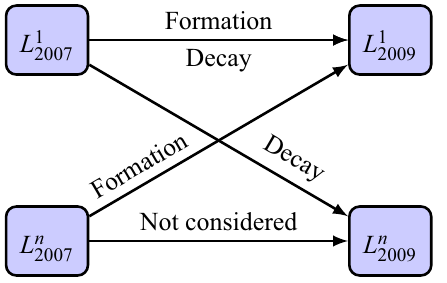
Figure 6. The relationships that have been considered for analyses. All pairs that were mutually in top 5 1 ranks in the year 2007 (represented by L 2007 ) and after a rise or decay in call activity still remain in top 5 in 1 −→ L n L 1 the year 2009 ( L 2009 ) along with pairs whose ranks become lower than 5 ( 2007 2009 : decay where n in n −→ L 1 the superscript represents any rank lower than 5) or rise from a lower rank to a higher one ( L 2007 2009 : formation) have been considered. Only pairs that remain in lower ranks have not been considered. The arrows have been labelled accordingly to show the change in the ranks. Relationships having users with ranks lower than 5 in 2007 and remain low in 2009 have not been